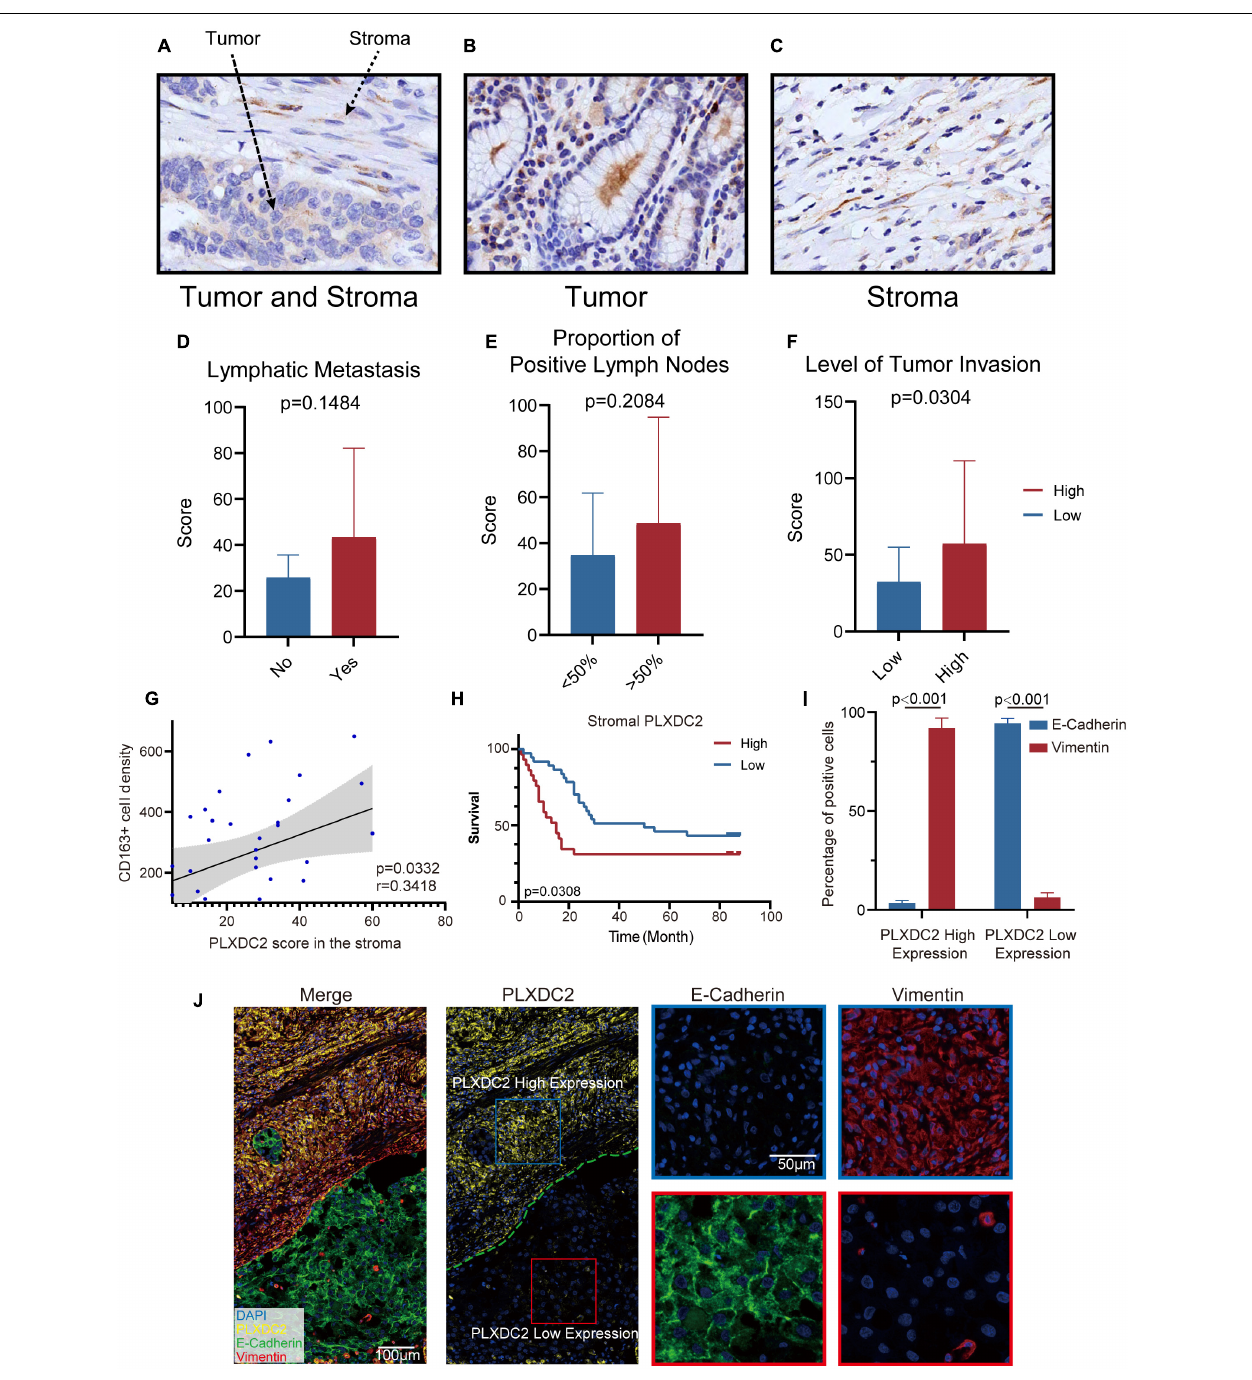
FIGURE 7 | PLXDC2 upregulation in Stroma indicates poor survival and high tumor invasion level. (A) PLXDC2 IHC staining images of GC tumor and stromal tissues (20x). (B) PLXDC2 IHC staining images of GC stromal tissues (20x). (C) PLXDC2 IHC staining images of GC tumor tissues [20x; (D) ] PLXDC2 staining scores of GC tumor tissues in samples group by whether lymphatic metastasis exist. Lymphatic Metastasis is consistent with N in AJCC standard. A paired t test was used for analysis. (E) PLXDC2 staining scores of GC tumor tissues in the samples group by comparing with 50% of the positive lymph nodes. The proportion of Positive Lymph Nodes refers to the proportion of positive lymph nodes in lymph nodes removed during operation. A paired t test was used for analysis. (F) PLXDC2 staining scores of GC tumor tissues in samples group by level of tumor invasion (high vs. low). Level of Tumor Invasion is consistent with T in AJCC standard. A paired t test was used for analysis. (G) Scatter plot showing the correlation of PLXDC2 score in the stroma and CD163 + cell density ( p = 0.0332, r = 0.3418). (H) Kaplan–Meier plot assessing survival according to High and Low PLXDC2 score in the stroma. p = 0.0308 by log-rank test. (I) mIHC staining scores exhibiting the percentage of positive cells of GC tumor tissues group by PLXDC2 expression level [high vs. low, p < 0.001; (J) ] mIHC staining images of GC section (Merge and PLXDC2-10x, E-Cadherin and Vimentin-40x).